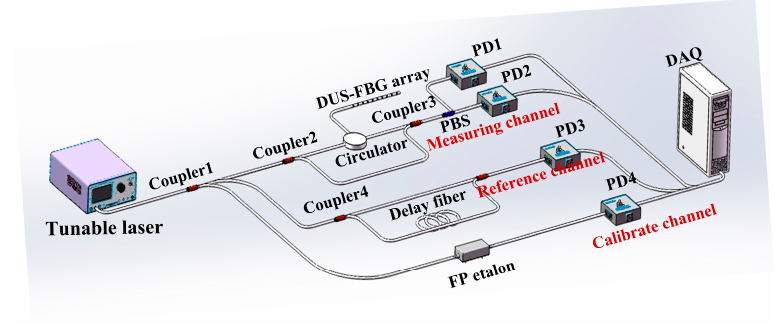
Figure 1. Improved OFDR demodulation system: PBS (Polarization Beam splitter); PD (Photodetector); DAQ card (Data Acquisition Card).